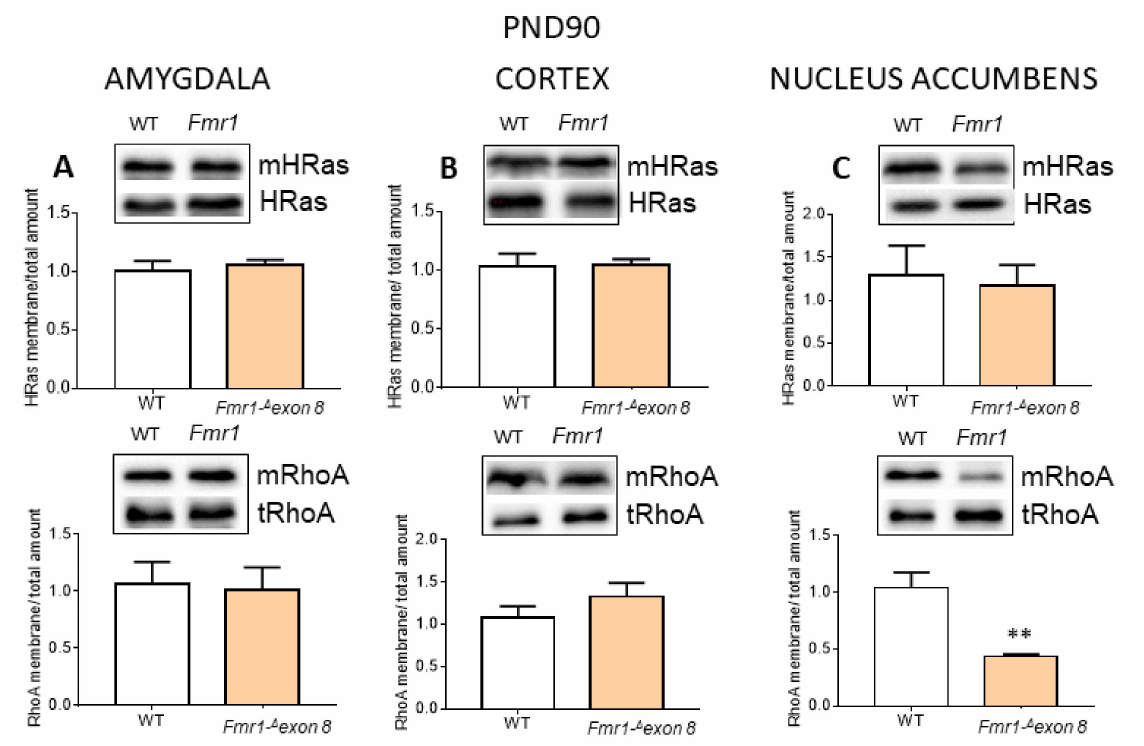
Figure 6. Membrane-bound and total level ratio of HRas and RhoA protein content in brain areas of Fmr1- ∆ exon 8 and WT adult (PND90) male rats. The figure illustrates a typical Western blot and a graph representing the ratio of the densitometric analysis between membrane-bound and total levels of HRas (top) and RhoA (bottom) in PND90 rats. The loading control was performed by using caveolin 1 (Figure S3). ( A ): amygdala; ( B ): prefrontal cortex (cortex); ( C ): nucleus accumbens. Values represent mean ± SD obtained from 6 animals performed in duplicate. Statistical analysis was carried out by using the unpaired Student’s t -test. ** = p < 0.01 vs.